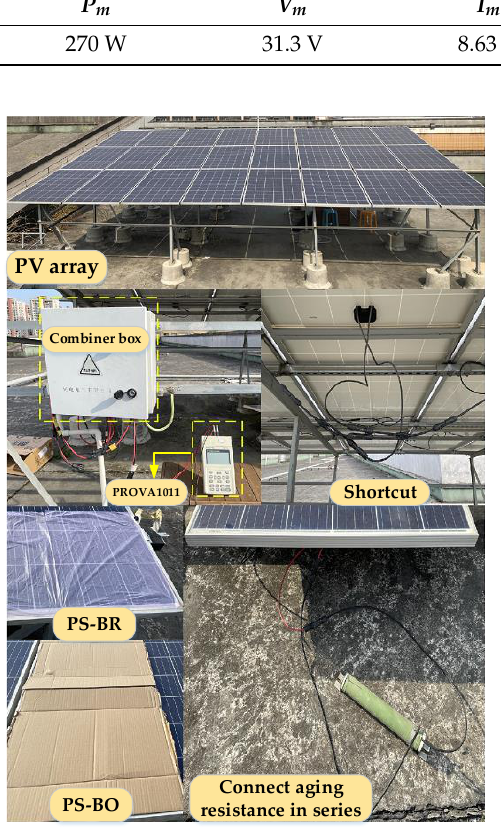
Table 1. The parameters of the PV module in field A under STC.